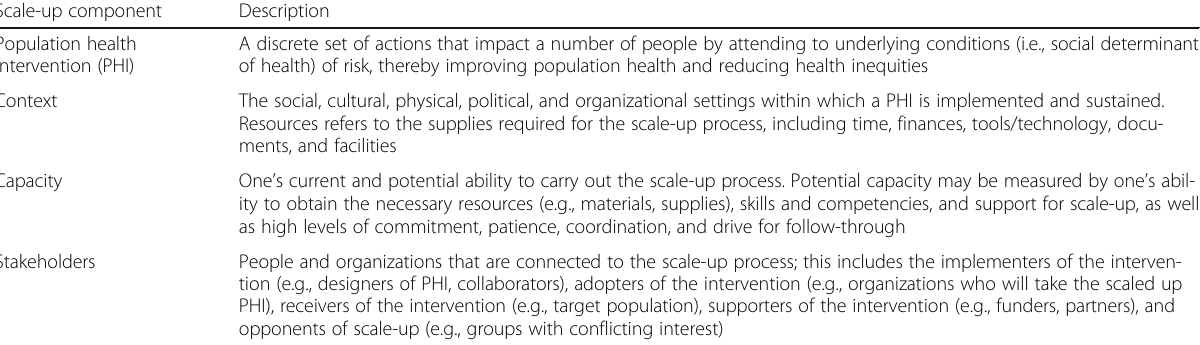
Table 4 Key scale-up components Scale-up component